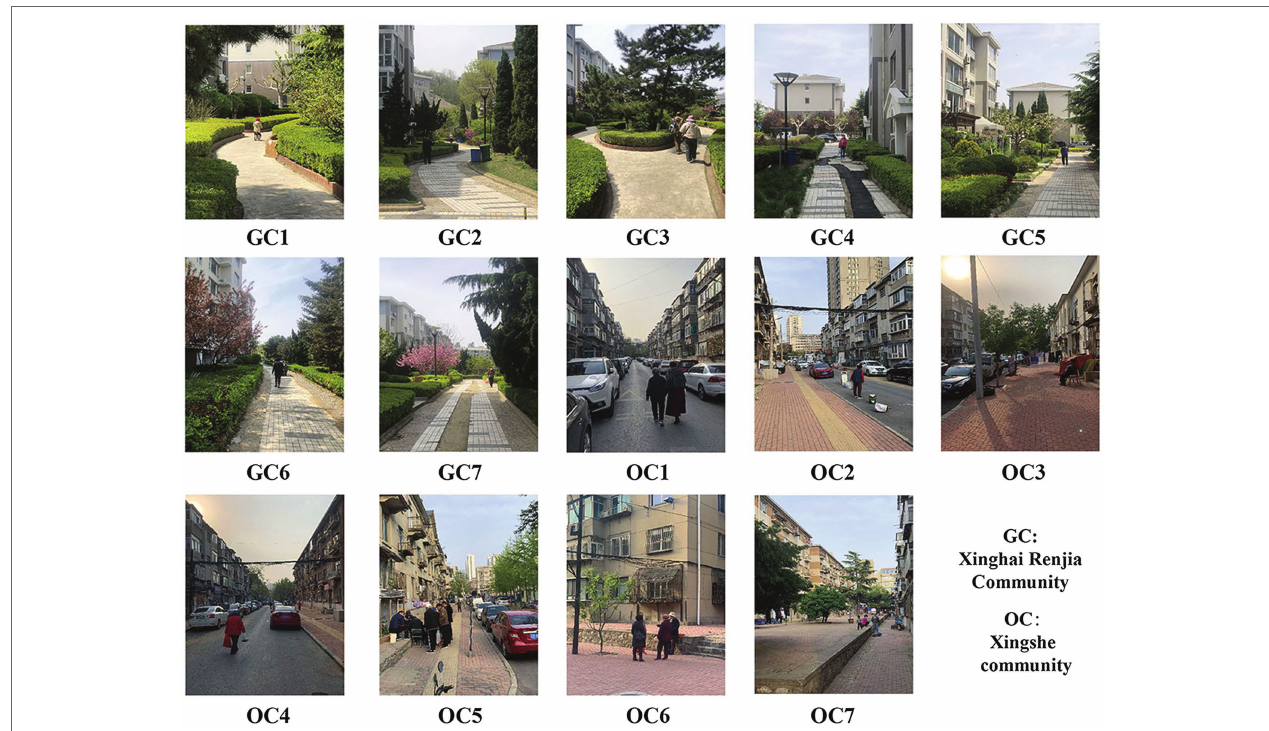
FIGURE 3 | Photos of the sites in Xinghai Renjia Community (GC) and Xingshe community (OC) where the surveys were